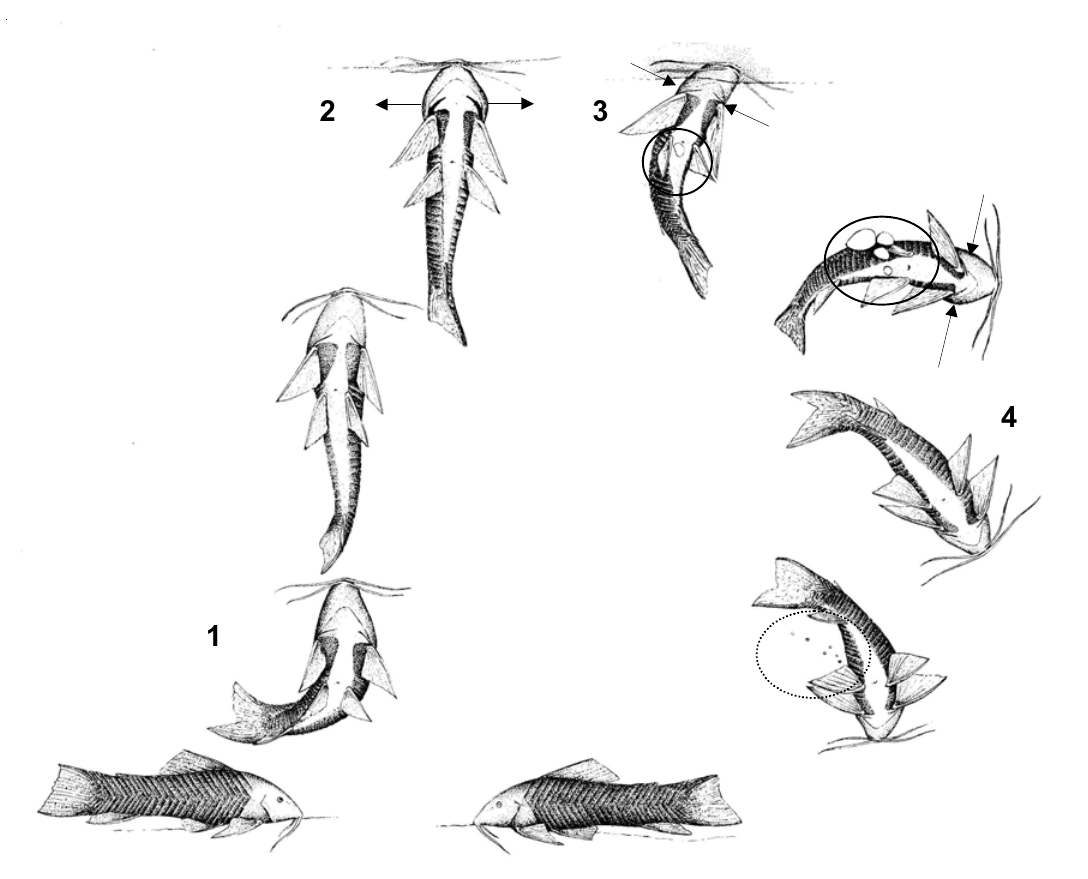
Fig. 1 . Air-breathing cycle of Hoplosternum littorale : 1) ascent to the water surface; 2) in contact with the surface the fish expands its oral cavity, inspiring air; 3) turning head down, with compression of the oral cavity pushing air into the intestine and causing the expiration of old air from the anus (circle, continuous line); 4) return to bottom and release of small air bubbles through the opercula (circle, dotted line). Arrows indicate the action of the buccal